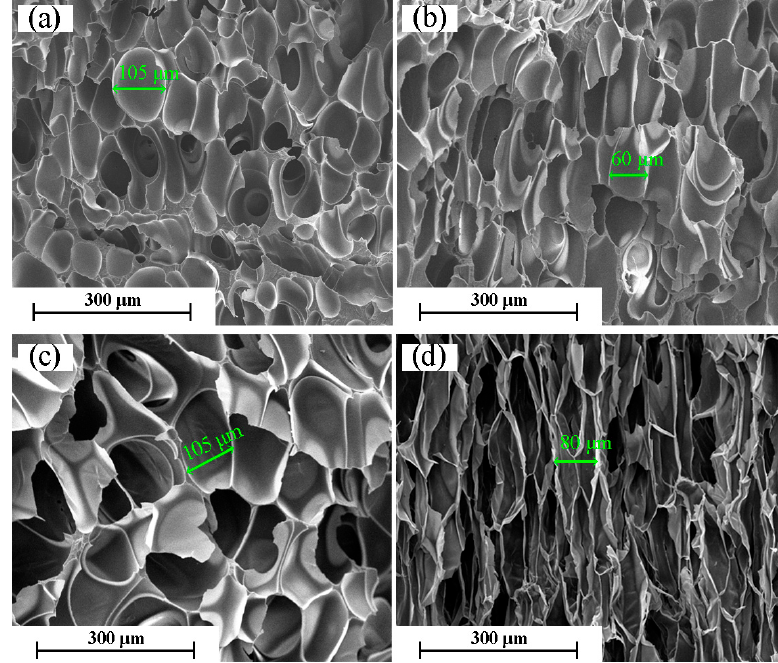
Figure 6. SEM micrographs for the foaming of PP (without TAIC) irradiated at different doses (kGy): ( a ) 10; ( b ) 20; ( c ) 30; and ( d ) 40.